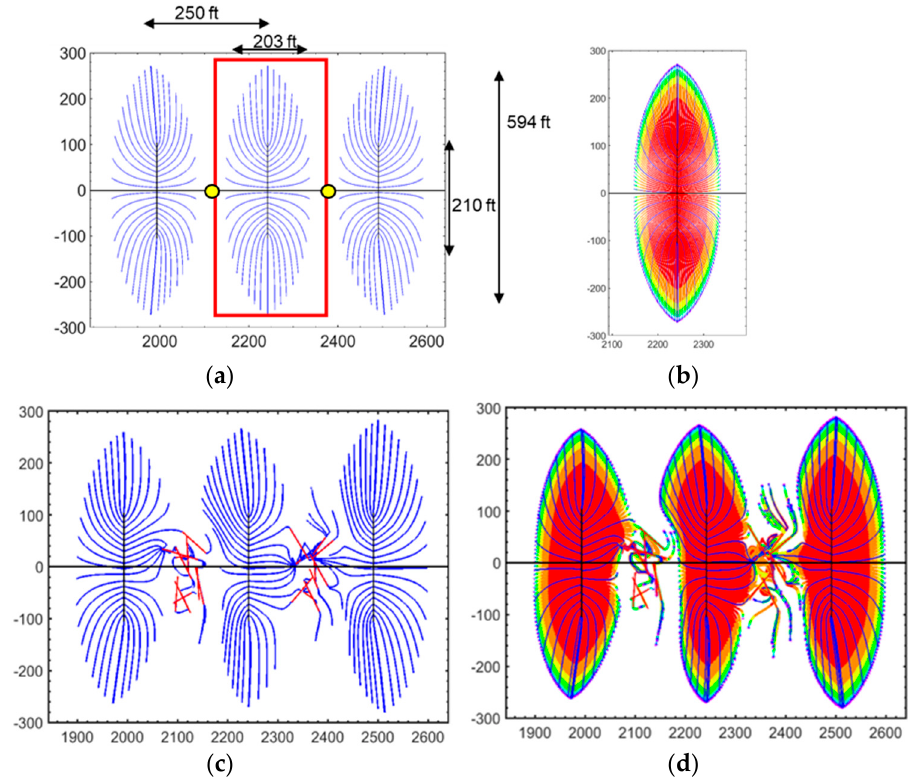
Figure 11. Flow simulations of fluid withdrawal paths around three hydraulic fractures in a horizontal well from the Permian Basin (map views). ( a ) Particle paths or fluid withdrawal paths based on well rate assuming homogenous reservoir (no natural fractures). ( b ) Drained rock volume after 30 years of production. Red region is drained in the first 3 years after which slower drainage occurs due to repaid decline of the well. ( c , d ): Distortions of flow paths and drained rock volume (marked by convective time of flight contours) due to presence of highly conductive natural fractures (red line segments) between the hydraulic fractures. Reproduced with permission from [53].